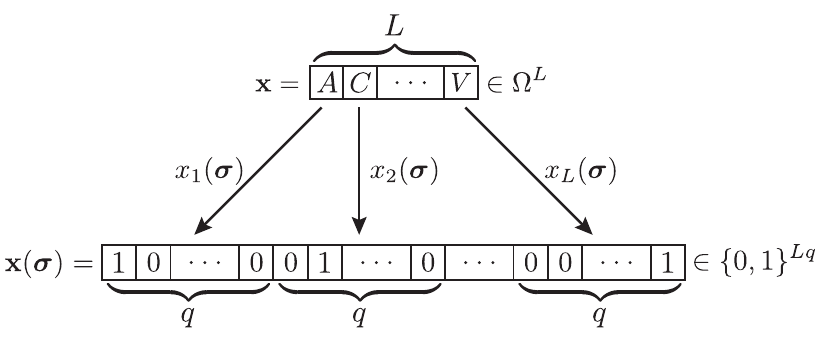
Fig 2. Illustration of binary embedding. The binary embedding 1 σ : Ω ! {0, 1} Lq maps each vector of categorical random variables, x 2 Ω L , here represented by a sequence of amino acids from the amino acid alphabet (containing the 20 amino acids and one gap element), Ω = { A , C , D , E , F , G , H , I , K , L , M , N , P , Q , R , S , T , V , W , Y , − }, onto a unique binary representation, x( σ ) 2 {0, 1} Lq